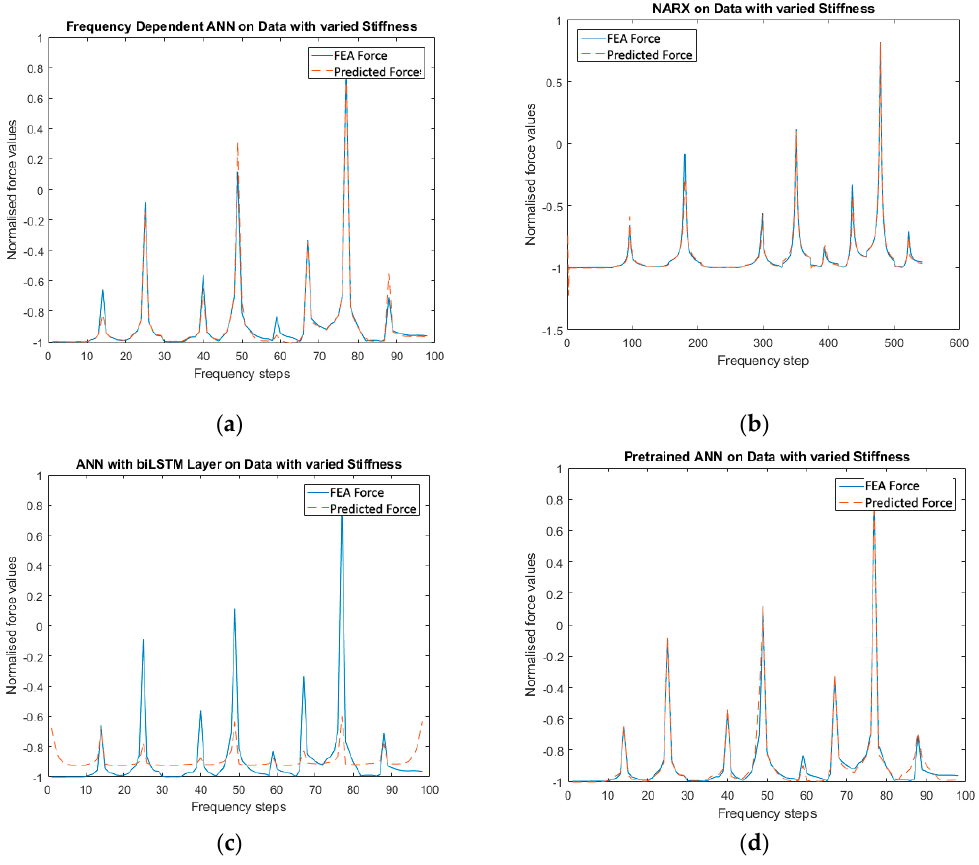
Figure 9. Finite element analysis (FEA) and predicted element force over frequency steps for the academic case with 6 sensors: ( a ) frequency-dependent ANN, ( b ) NARX with increased number of frequency steps, ( c ) ANN with biLSTM layer, and ( d ) pretrained ANN.